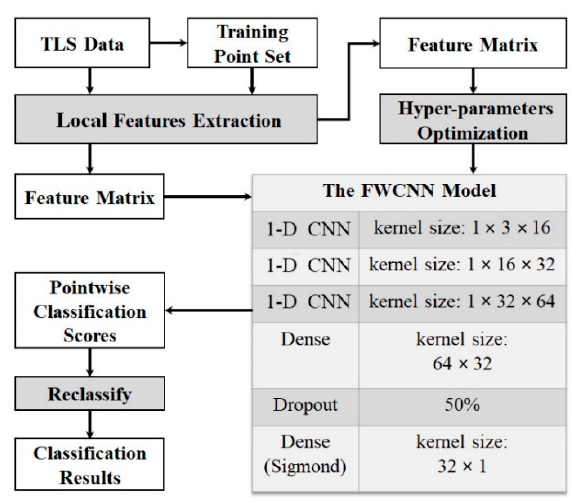
Figure 2. The flowchart of running the FWCNN model to separate foliage and woody points from a TLS dataset. Meanwhile, the architecture of the FWCNN model is shown in this figure.